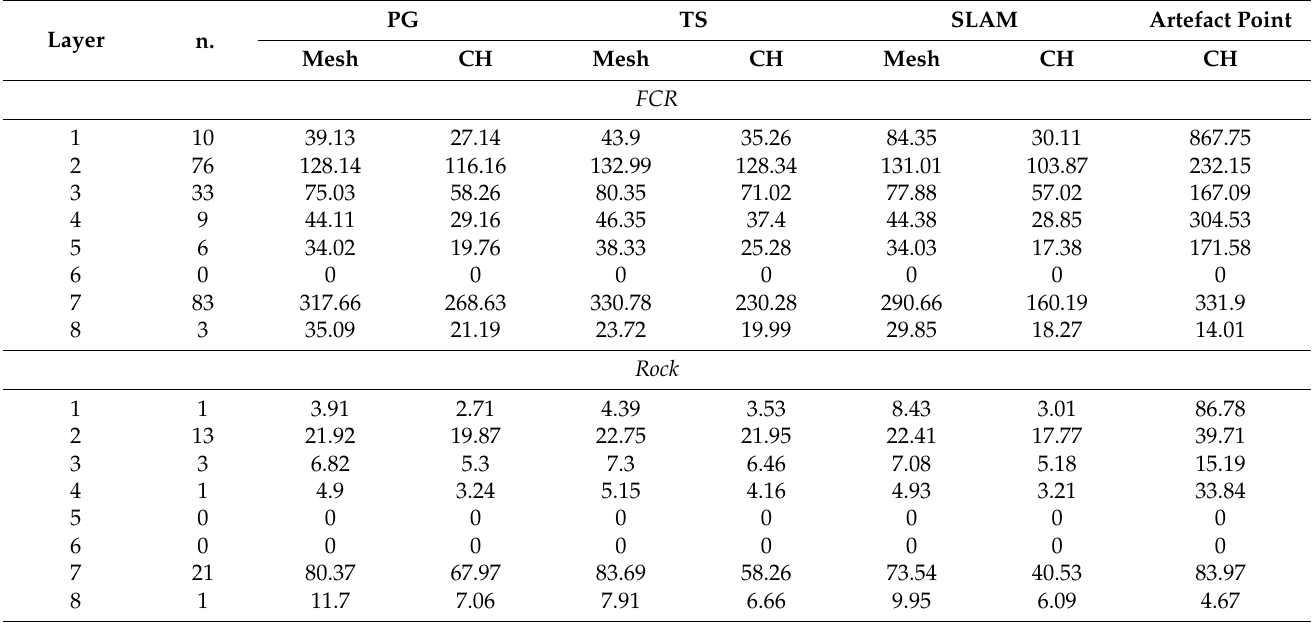
Figure 11. Visual comparison of the artefact densities (m 3 ) for each artefact type and layer, by method. Note y -axis is log-transformed. Table 6. Density of artefacts by layer for each object type in m 3 . FCR = fire-cracked rock; rock = natural rock; SA = stone artefact. Mesh = triangulated